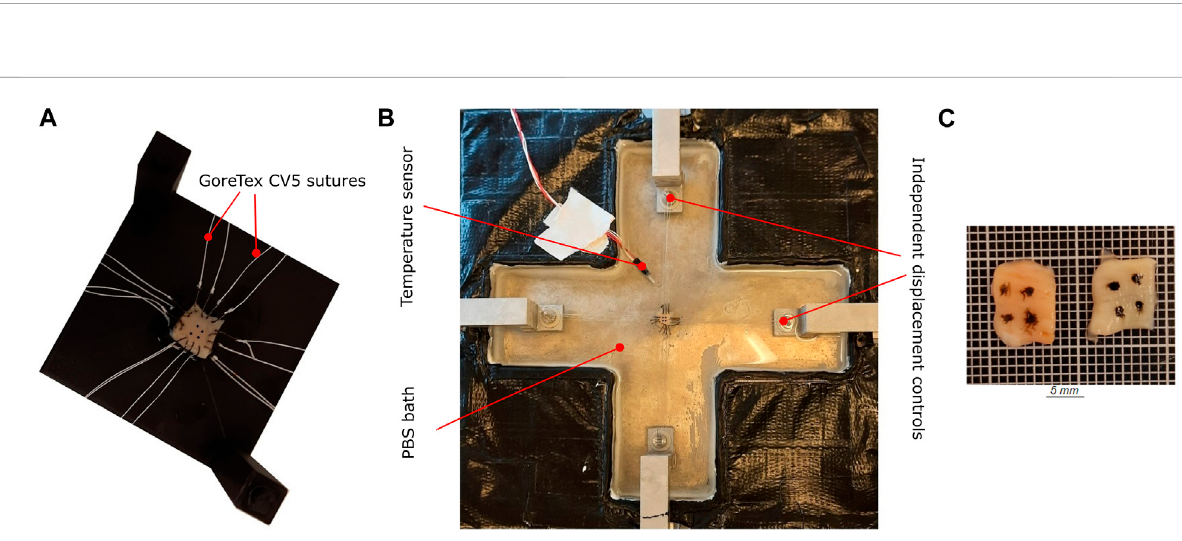
FIGURE 2 Samplepreparationandmountingprotocolforbiaxialtensiontesting (A) Thesampleisplacedona3D-printedtemplate.Thesampleisattachedwith barblesshooksandsutures,markedusingtissuemarkingdye. (B) Custom-builtbiaxialtensiletestset-up.ThesampleissubmergedinPBS. (C) Thesample after optical tissue